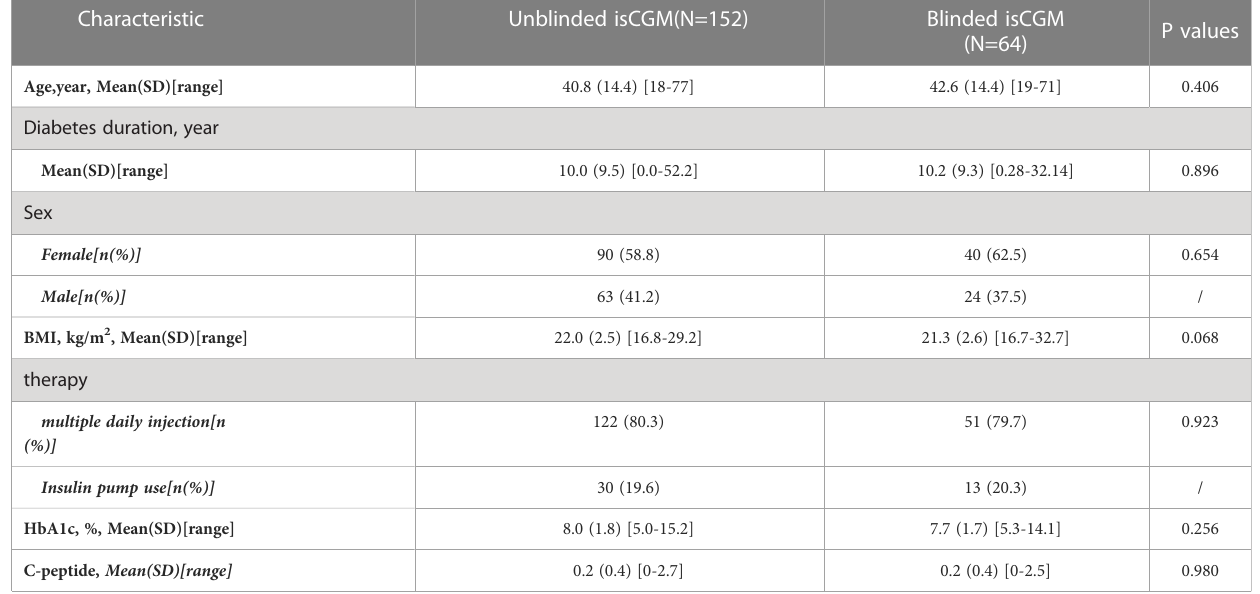
TABLE 1 Baseline characteristics of participants in a study of the ef fi cacy of unblinded and blinded intermittently fl ash continuous glucose monitoring on glycemic control in adults with type 1 diabetes. Characteristic Unblinded isCGM(N=152) Blinded isCGM